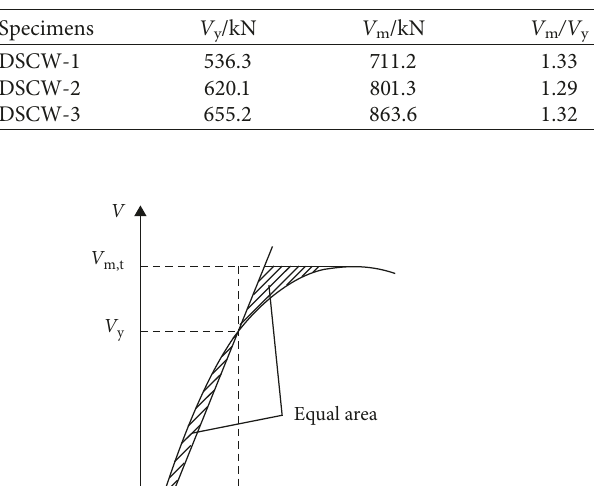
Figure 6: Lateral load versus top displacement relationship. (a) DSCW-1. (b) DSCW-2. (c) DSCW-3. (d) Envelope curves. Table 2: Lateral load resisting capacity.